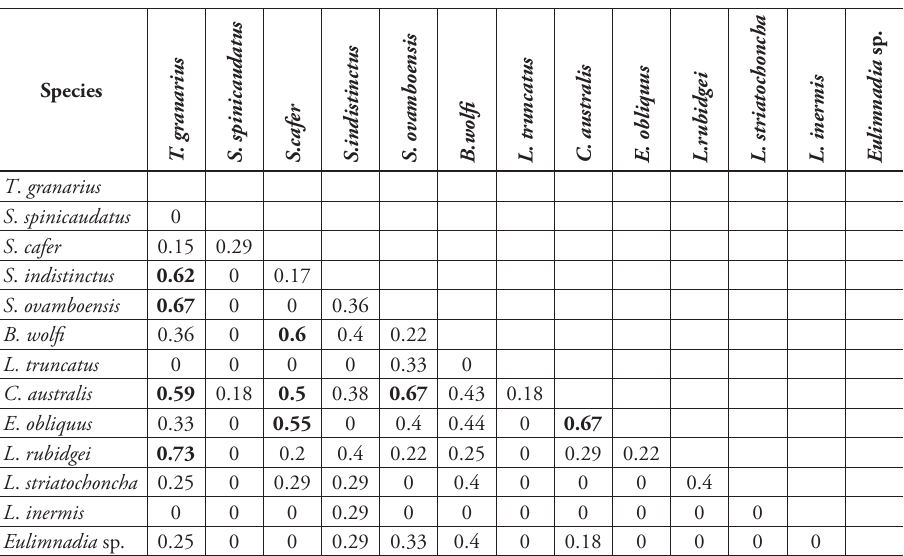
Table 2. Fager’s affinity indices between pairs of large branchiopod species in waterbodies in the Eastern Cape Karoo collected in November 2014 and April 2015.